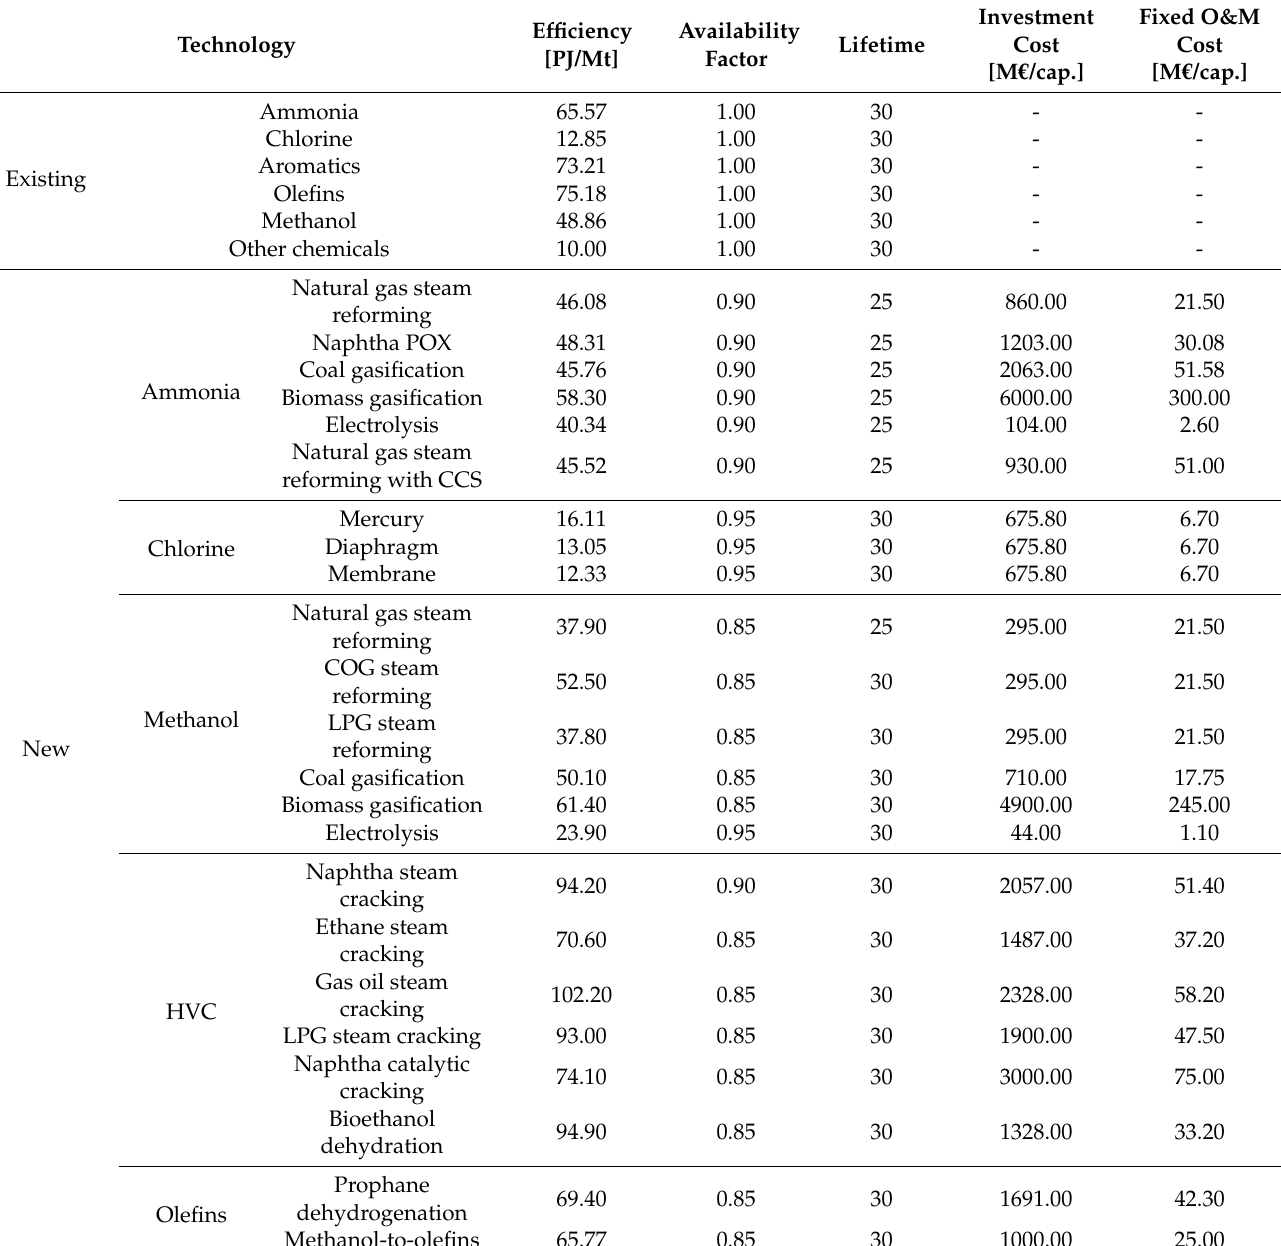
Table A2. Techno-economic characterization for chemical industry technologies